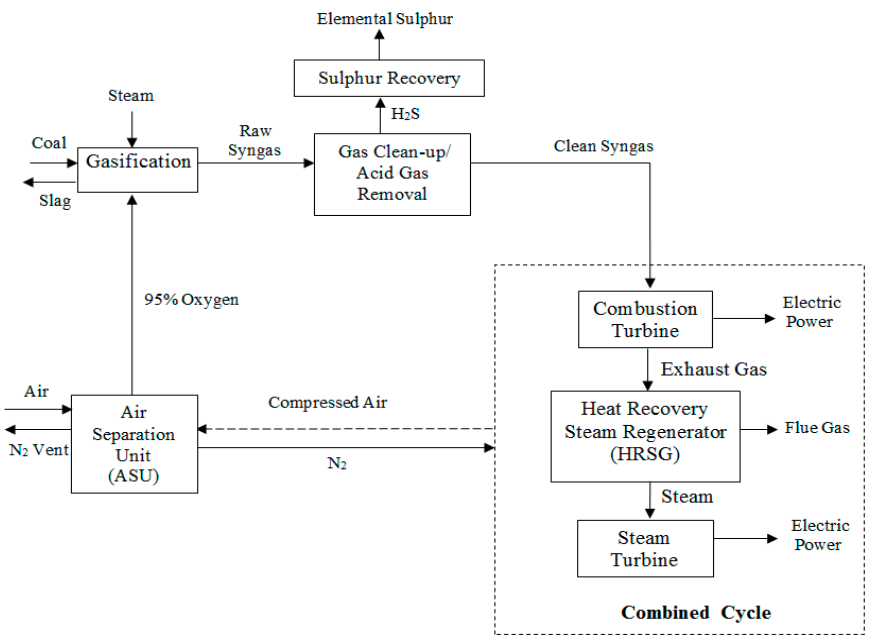
Figure 5. Flow diagram of IGCC without pre-combustion co 2 capture process. Table 5. Main model parameters for IGCC electrical generating station including CO 2 capture process (Selexol ® ).